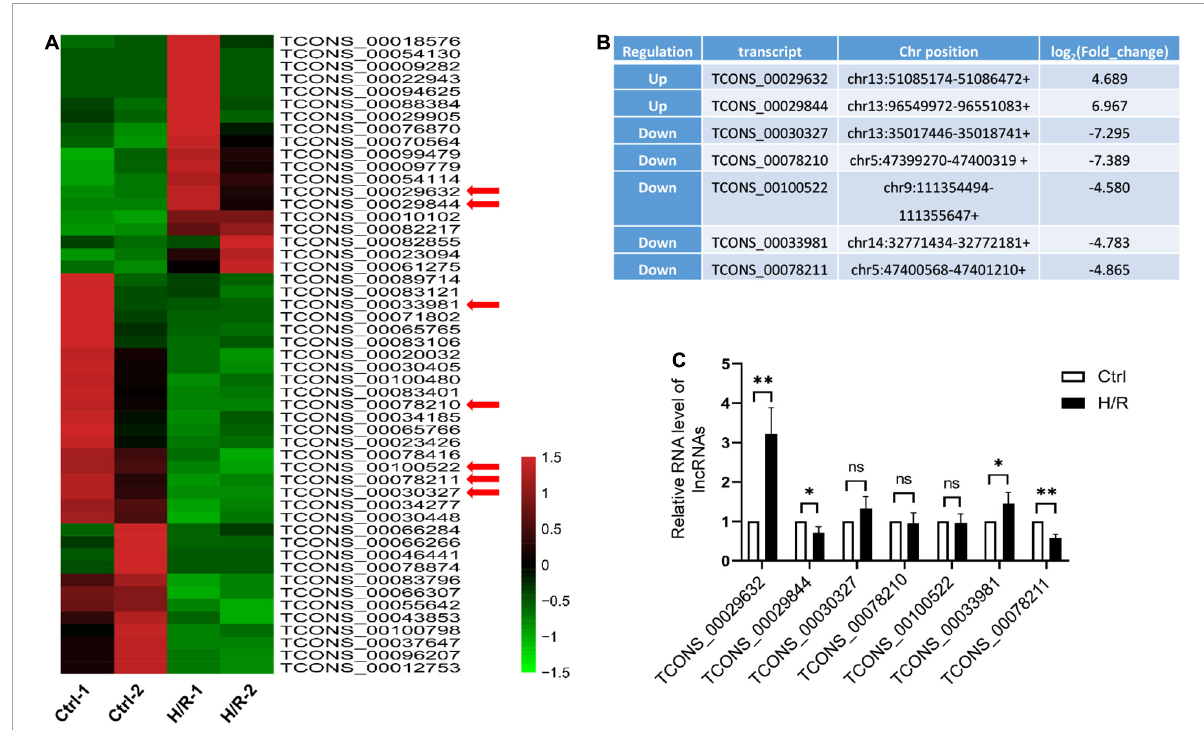
FIGURE1 H/R alters the expression of lncRNAs. (A) Heat map of RNA sequencing results of dysregulated lncRNAs (fold change > 3) in Ctrl and H/R cells. (B) Seven novel lncRNAs with the most obvious alterations in H/R-treated H9c2 cells. (C) The expression of seven selected lncRNAs in Ctrl and H/R cells were analyzed by qRT-PCR ( n = 5). The Data are presented as means ± SD. * P < 0.05, ** P < 0.01, ns = not